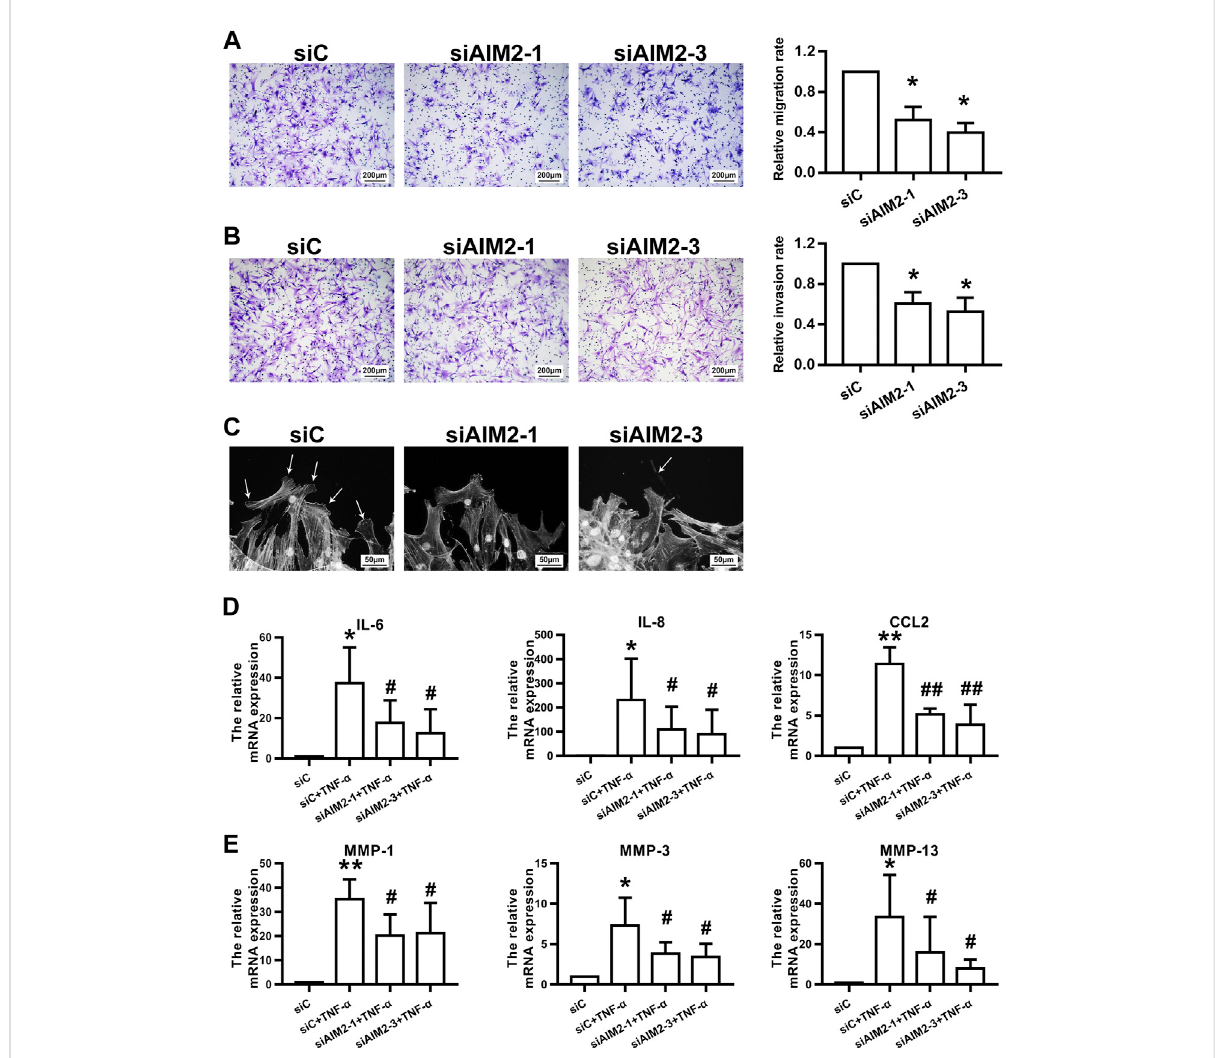
FIGURE 4 AIM2 knockdown regulated RA FLS migration and invasion. RA FLSs were transfected with siRNAs against AIM2 (siAIM2-1, siAIM2-3) or control siRNA (siC). (A,B) Effect of AIM2 knockdown on the migration and invasion of RA FLSs. RA FLS migration (A) and invasion (B) were measured with a Boyden chamber assay. The relative migration and invasion rates were calculated by counting migrated or invaded cells and then normalized to that in control group. Representative images (original magni fi cation, ×100) are shown. Data show the mean ± SD of samples from at